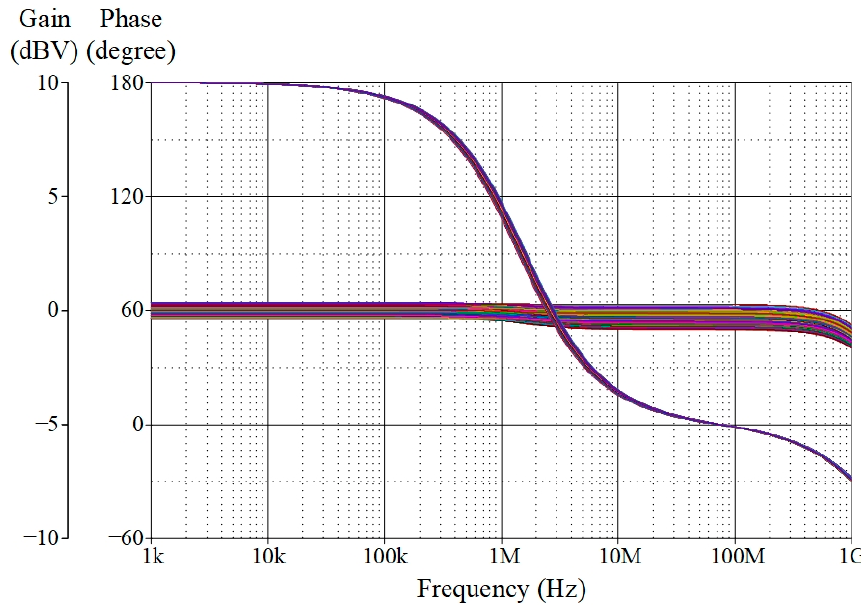
Figure 11. Monte-Carlo analysis results of the VM AP response at f p = 1.59